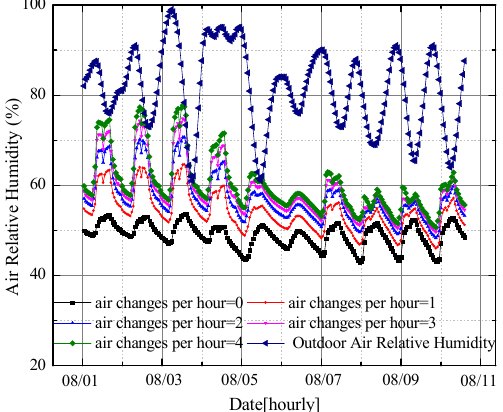
Figure 12. Relative humidity with different air exchange from 1 August to 10 August.